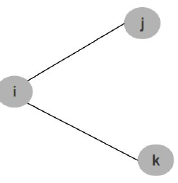
Figure 3. Example of topology of a